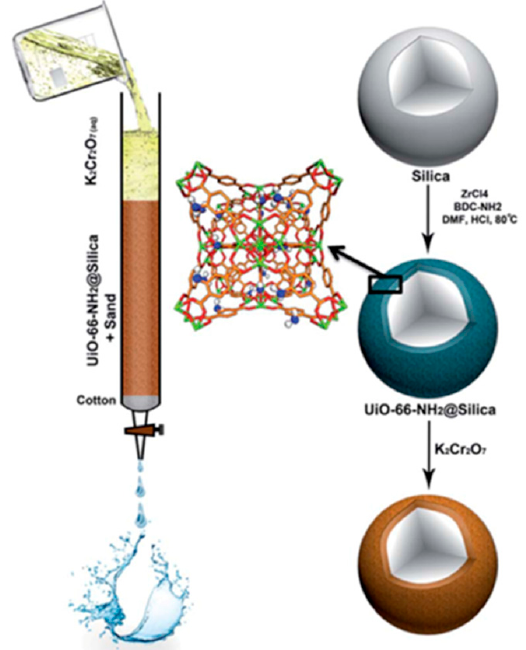
Figure 5. Hierarchical buildup of the UiO-66-NH 2 @silica and the column packing for (Cr 2 O 7 ) 2 − removal. Reproduced from [63], with permission from the Royal Society of Chemistry, 2018.